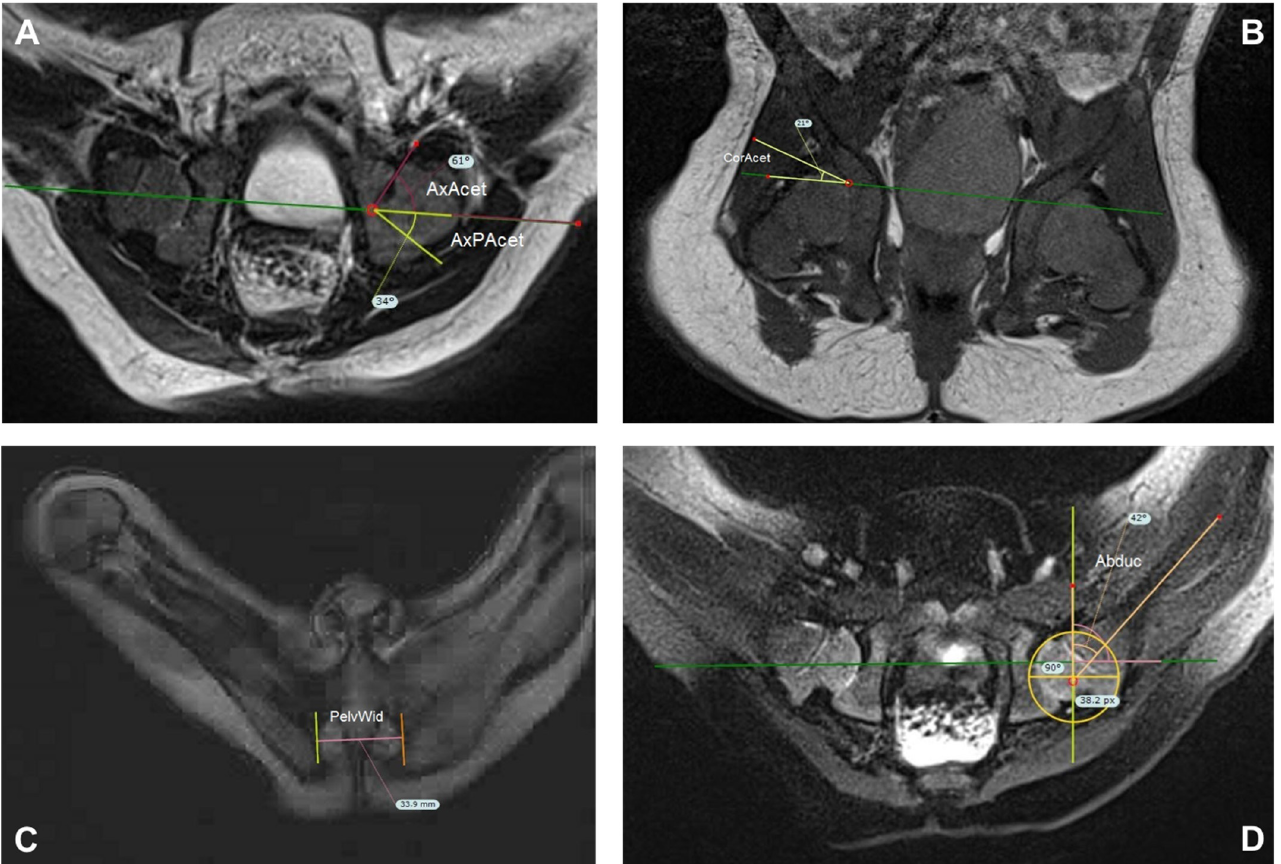
Figure 4. Overview of the measurement technic in the MRI described by Jaremko and performed in TraumaCad. ( A ) AxAcet/AxPAcet: Select the axial image for which the acetabular cup appears deepest. The bony anterior acetabulum index (red) is the angle is made between Hilgenreiner’s line (green) and a line joining the anterior edge of the bony acetabulum to the lateral edge of the triradiate cartilage. The bony posterior acetabular index (yellow) is measured similarly at the posterior joint line. ( B ) CorAcet: Select Slice were the acetabular roof is steepest. Angle (yellow) between Hilgenreiner`s line (green) and a line joining the superior edge of the bony acetabulum to the lateral edge of the triradiate cartilage. ( C ) PelvWid: widest distance between medial ischial walls at the pelvic inlet, below the hip joints ( D ) Abduc: On the slice showing the largest diameter of the most normally positioned femoral bead, draw Hilgenrainer’s line (green) between anterior lateral edges of triradiate cartilage in the same fashion as on the coronal images. Abduc angle (orange) is the angle between the line along the mid femoral shaft and a perpendicular to Hilgenreiner’s line. (AxAcet AxPAcet = anterior/posterior bony axial acetabular angles, CorAcet = coronal acetabular angle, PelvWid = Pelvic width, Abduc = hip abduction angle) [26].